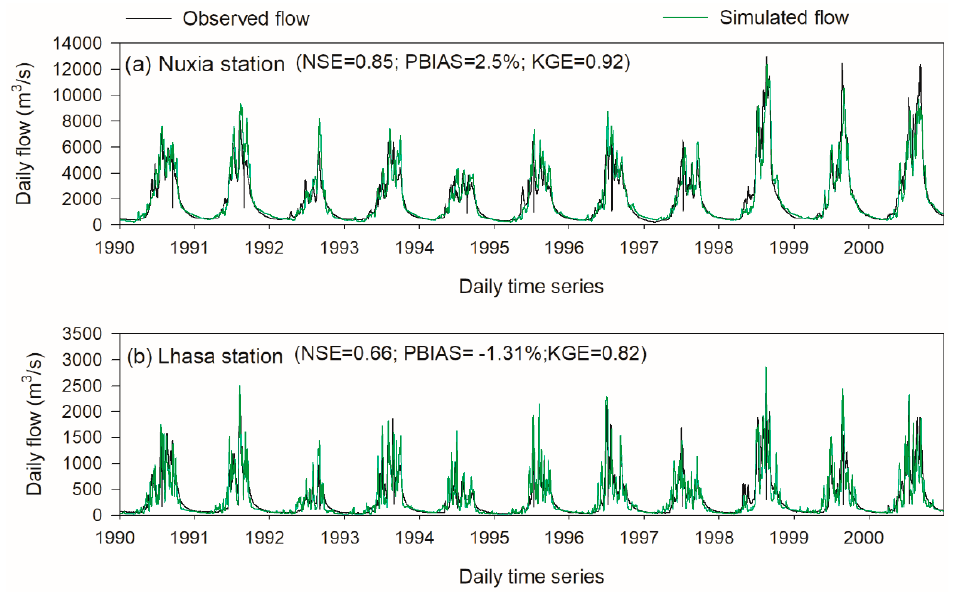
Figure 6. Daily flow simulation at Nuxia ( a ) and Lhasa hydrological stations ( b ) during the calibration period